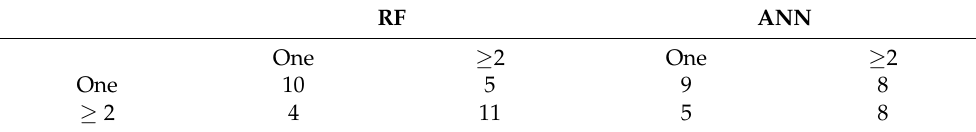
Table 5. Comparison (confusion matrix) for the two best models.